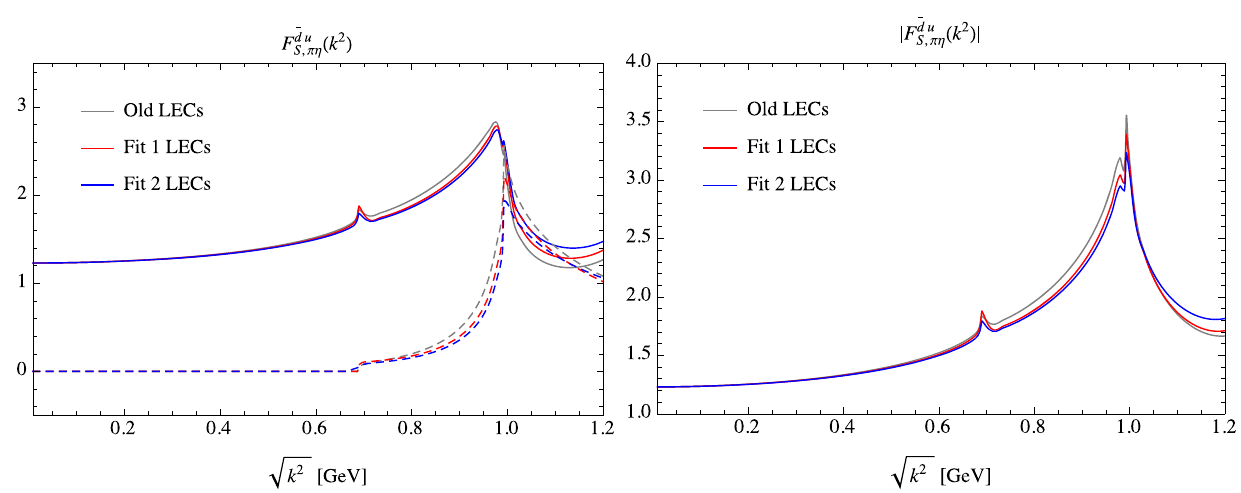
Fig. 1 Left panel: real (red solid lines) and imaginary (blue dashed lines) parts of F πη ( k 2 ) . Right panel: the norm of F πη ( k 2 ) . For further details, see Ref.